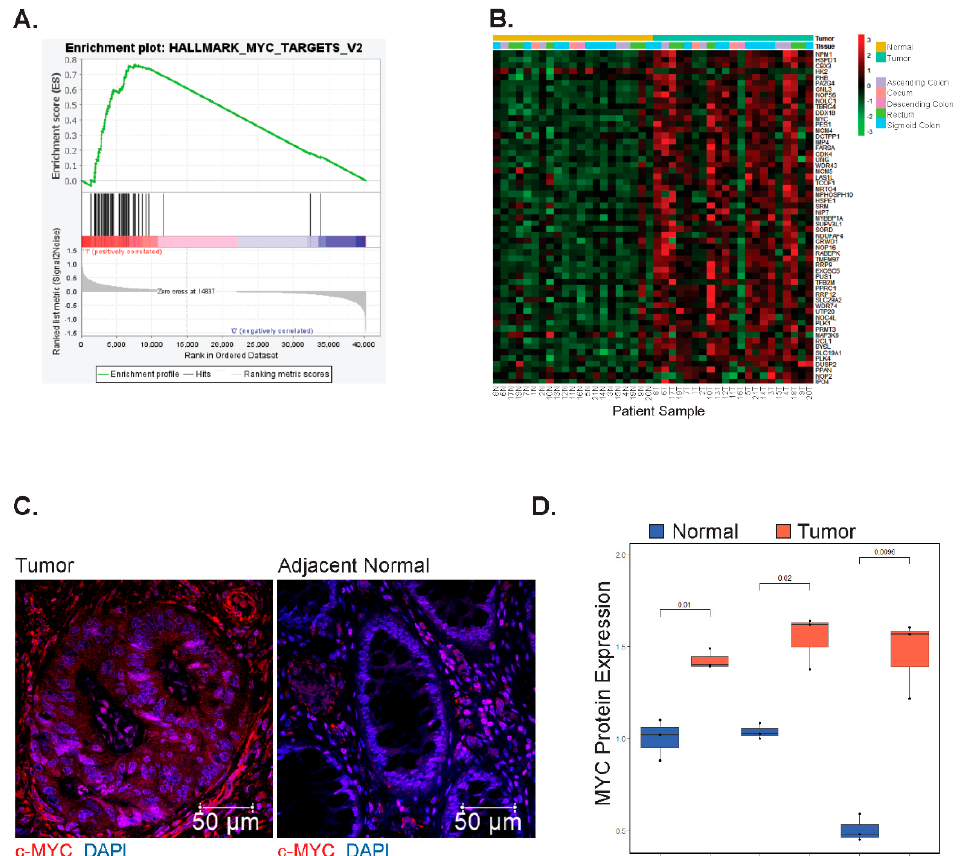
Figure 2. MYC and its downstream targets are differentially expressed in EOCRC. ( A ) Gene set enrichment analysis (GSEA) of genes comprising the hallmark MYC target set in tumors compared with patient-matched uninvolved colonic segments (Nominal p -value = 0.011, Normalized Enrichment Score: 1.52). ( B ) Heatmap of row-scaled gene expression of MYC and its downstream targets in tumors and adjacent colonic segments. Patients are arbitrarily assigned 1–21 and N represents uninvolved tissues, whereas T represents tumors. ( C ) Representative IF images of tumors and matched normal samples stained using a primary antibody against MYC. ( D ) Quantification of MYC positive nuclei from 3 fields of view per sample (N = 3 matched samples).